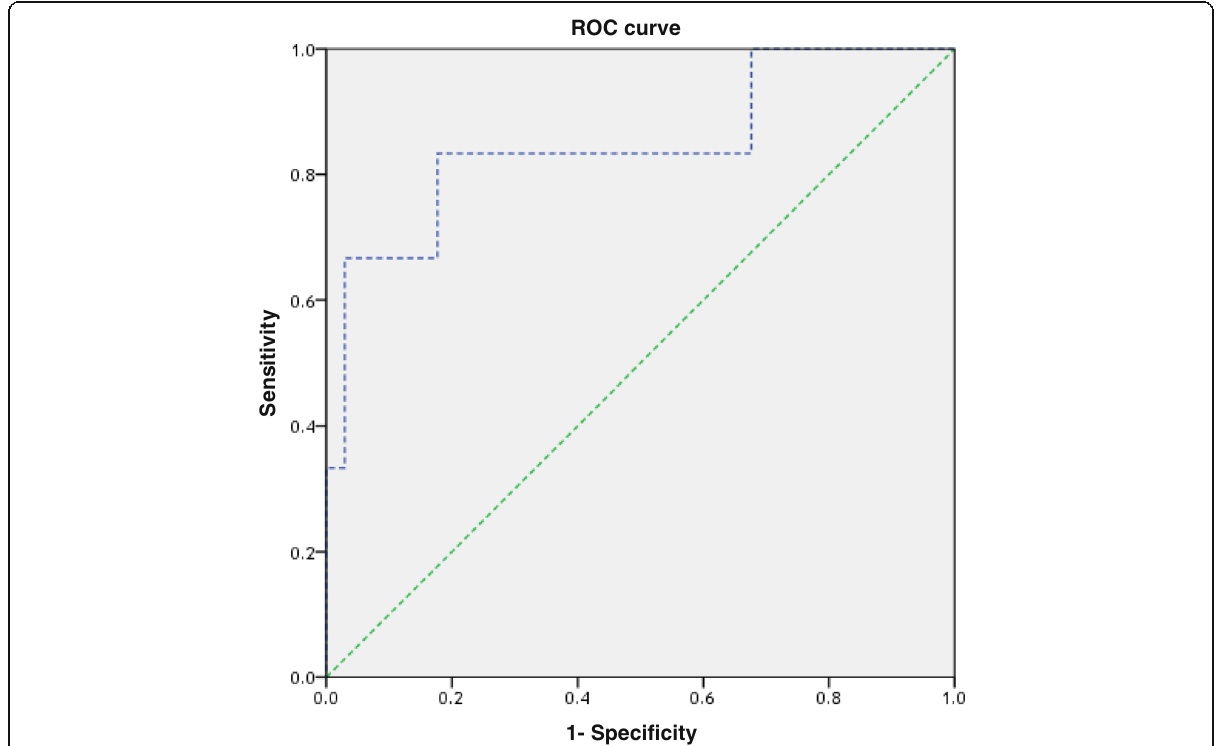
Fig. 1 ROC curve for detection of NLR cutoff with regard to